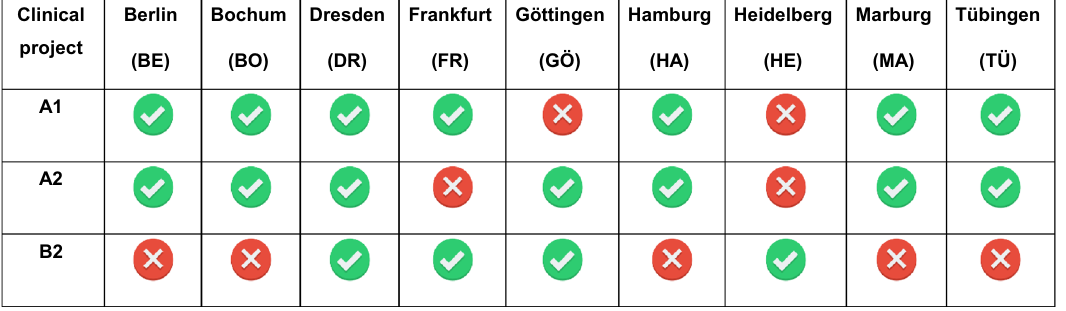
Table 1 Involvement of BipoLife study centers in the neuroimaging projects A1, A2 and B2